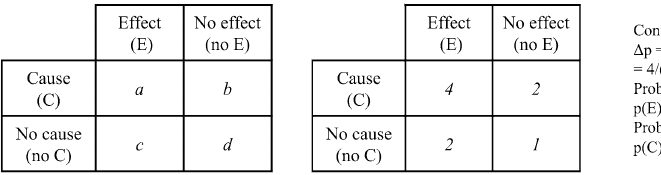
Figure 1. Contingency matrix with the four trial types that could be presented on the contingency learning task. There are four different pieces of information or trials (“a”, “b”, “c”, and “d trial) as a function of whether or not the cause and the effect are present (left panel). From this information, a measure of contingency (Δp) 42 can be computed as the probability of the effect conditional on the cause occurrence minus the probability of the effect conditional on the cause absence (see example of these computations on the right panel). Positive values indicate a generative causal relationship between the events, and negative values indicate a preventative causal relationship. When both events are not related to each other, the index equals zero and the contingency is null. Causal illusions are usually detected on null contingency settings when the cause and the effect appear with a high